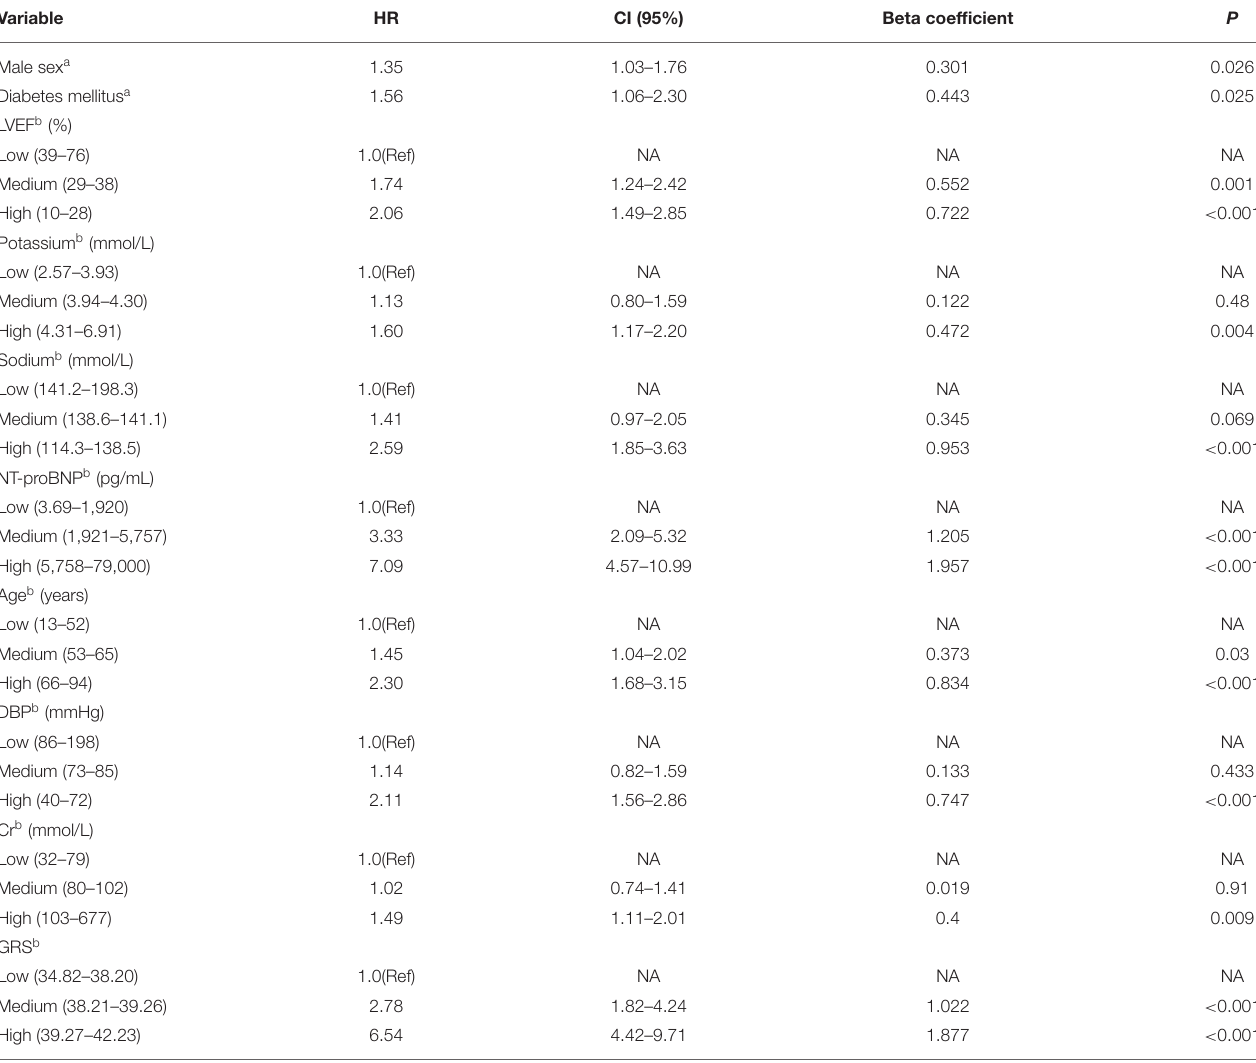
TABLE 6 | Cox regression analysis of association between HF-related mortality risk and continuous variables categorized into groups of low, medium, and high. Variable